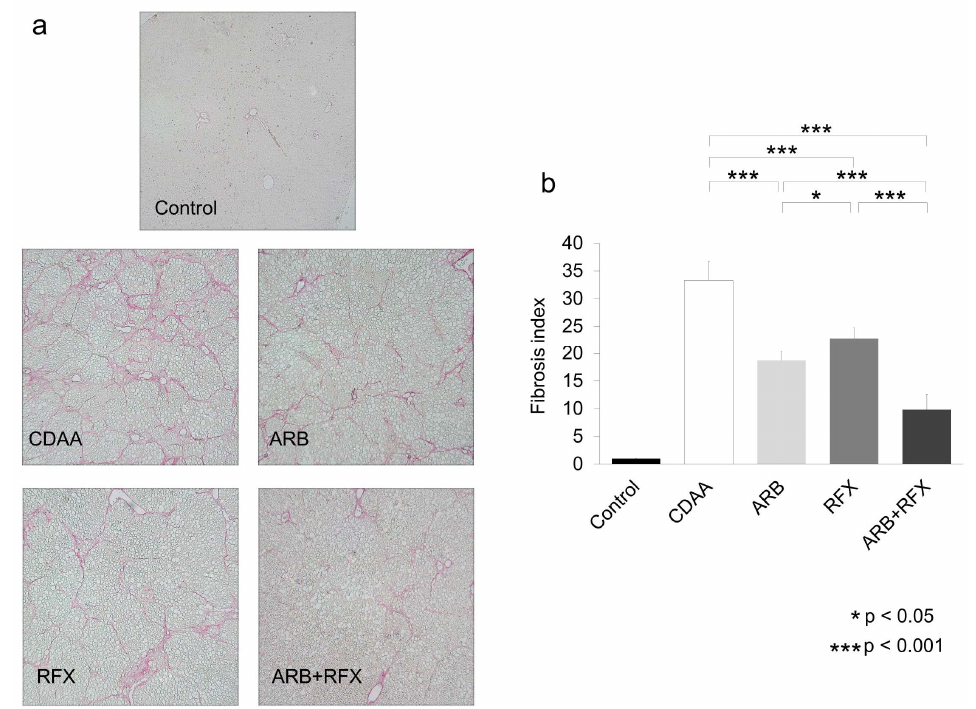
Figure Figure 1. ( a ) Microphotographs of liver sections with Sirius red (magnification; 100 folds). ( b ) Semiquantitative analysis confirmed the histological findings. No fibrosis was observed in the control group. Liver fibrosis was observed in the CDAA group. Monotherapy with an ARB demonstrated a significant inhibitory effect. Monotherapy with RFX demonstrated a significant inhibitory effect. The combination of an ARB and RFX exerted a greater inhibitory effect than that conferred by either monotherapy. Values represent the mean ± SD. * p < 0.05, *** p < 0.001.